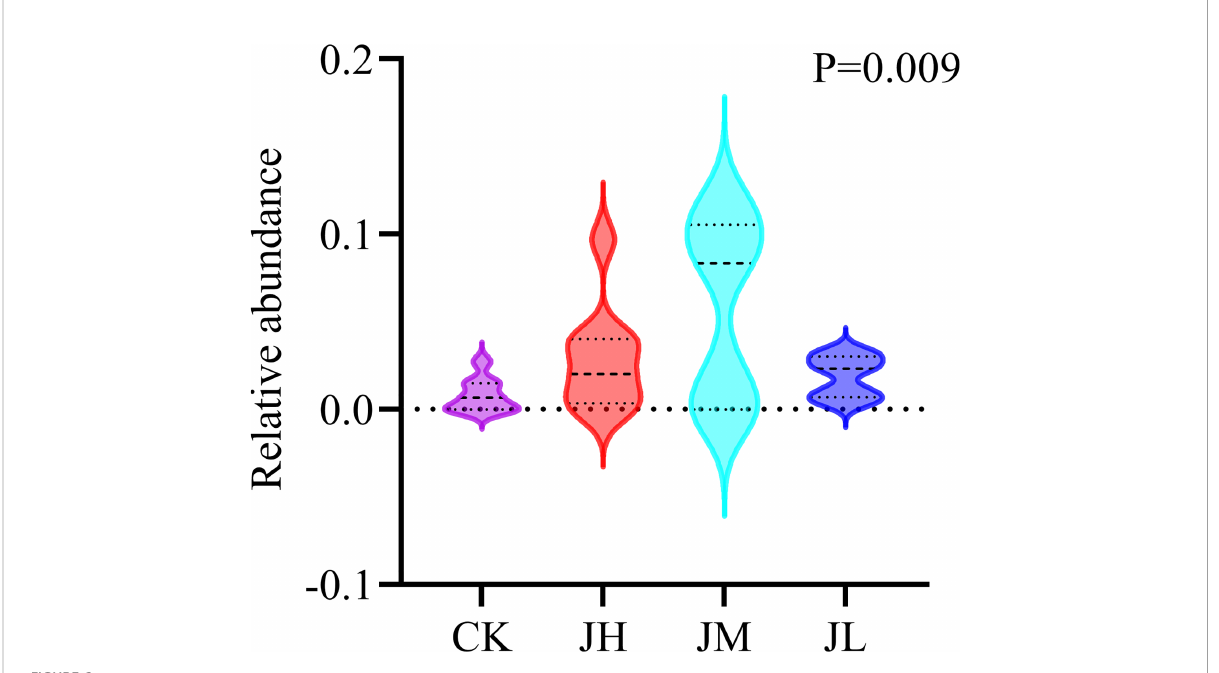
FIGURE 6 Analyzed of different fungal abundances in different treatment groups.